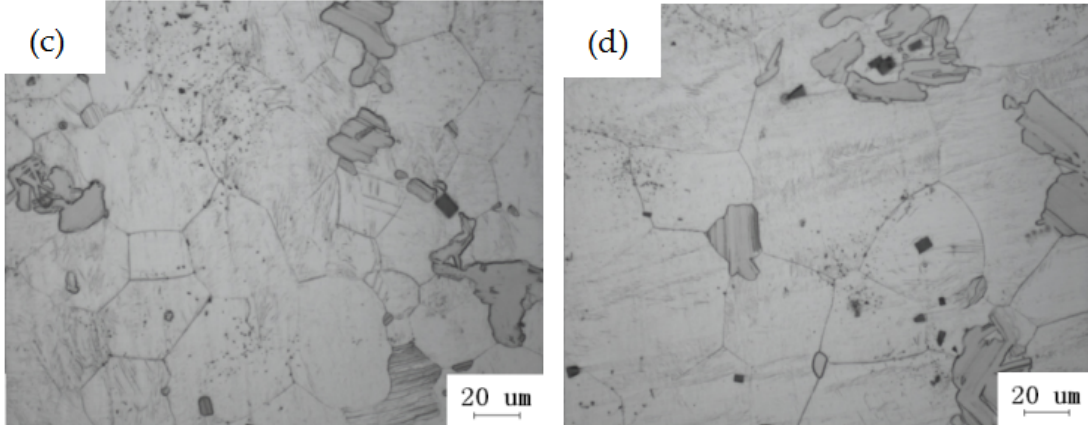
Figure 4. Optical microscopy (OM) images of the alloy after different solid solution treatments. ( a ) 420 °C × 12 h. ( b ) 450 °C × 12 h. ( c ) 480 °C × 12 h . ( d ) 510 °C × 12 h.